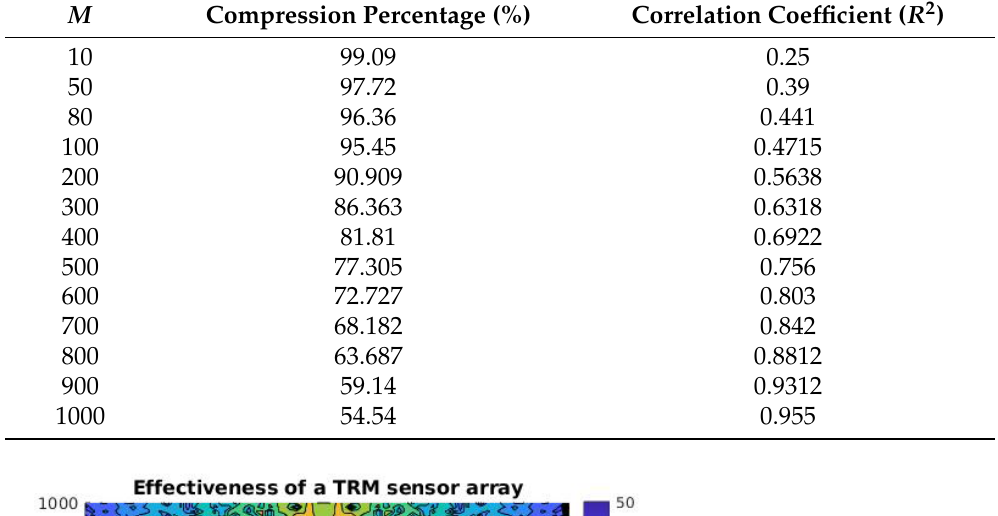
Table 1. Information about the compression of a bulk carrier signal with rate sampling of 2.2 kHz.